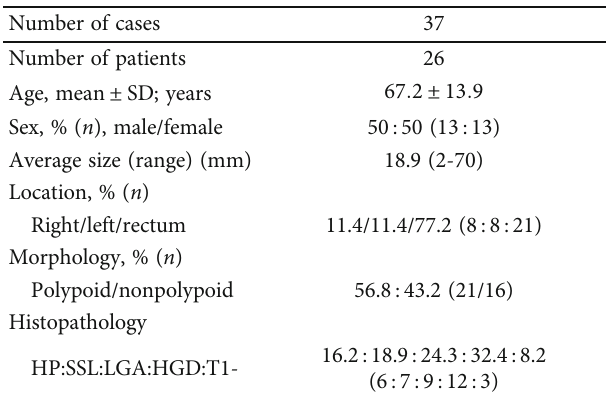
Table 1: Clinical characteristics of the 37 lesions observed with BLI-LED and